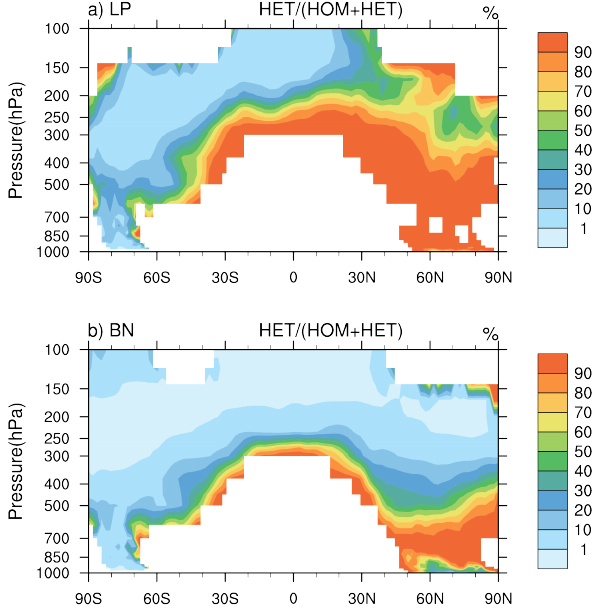
Fig. 4. Percentage contribution from heterogeneous ice nucleation Figure 4. Percentage contribution from heterogeneous ice nucleation to total ice crystal to total ice crystal number concentration diagnosed in the ice nucle- number concentration diagnosed in the ice nucleation parameterizations for the combined ation parameterizations for the combined LP and BN LP and BN cases.